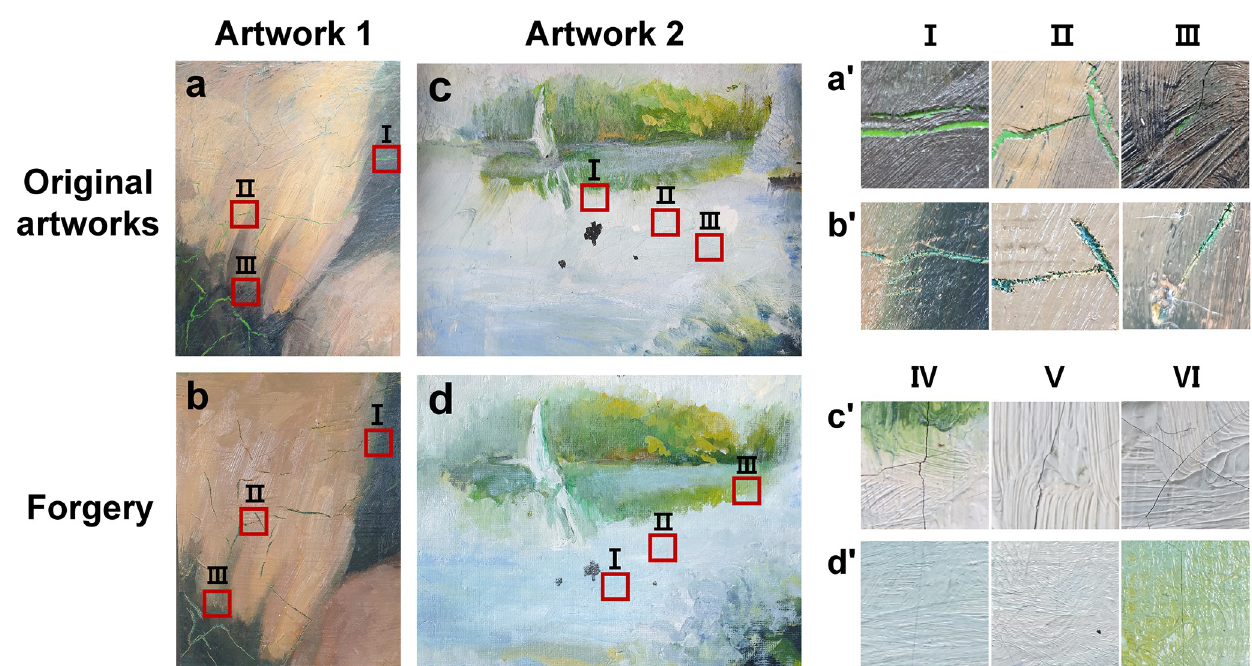
Fig 3. Images of Artwork 1 (a, b) and Artwork 2 (c, d) showing the area selected by the OCT system and enlarged views of the cracks in each area. The cracks were selected because the paint characteristics of each work were prominent. They were then analyzed with the OCT system. Enlarged images of original cracks (a’, b’) and fake cracks (c’, d’) at the selected location in Artwork 1 and Artwork 2